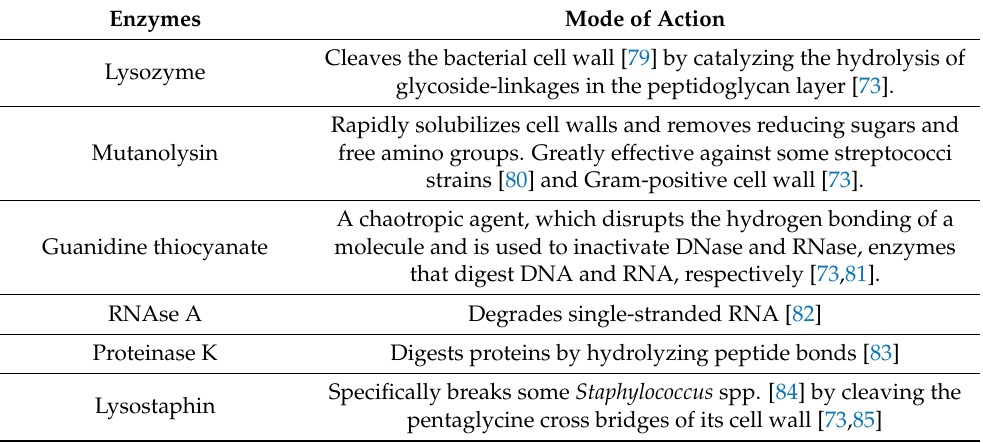
Table 1. Typical chemical and enzymatic lysing agents. Enzymes Mode of Action Cleaves the bacterial cell wall [79] by catalyzing the hydrolysis of Lysozyme glycoside-linkages in the peptidoglycan layer [73]. Rapidly solubilizes cell walls and removes reducing sugars and Mutanolysin free amino groups. Greatly effective against some streptococci strains [80] and Gram-positive cell wall [73]. Guanidine thiocyanate RNAse A Proteinase